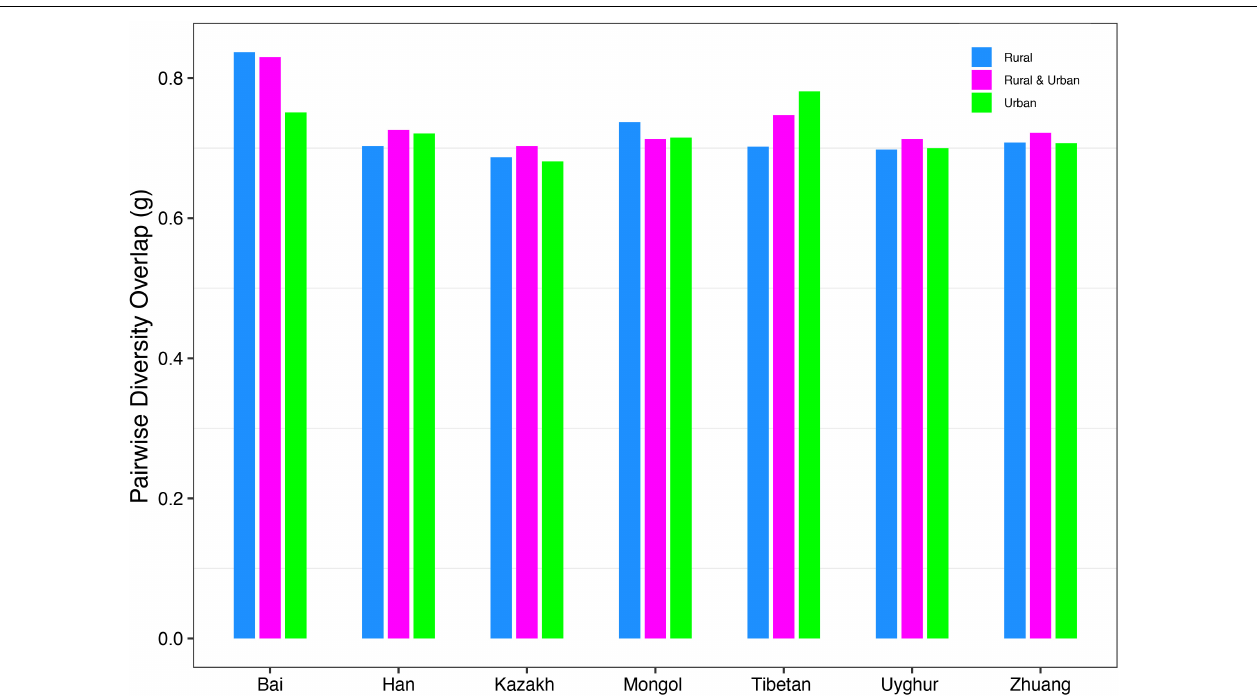
FIGURE 5 | The PDO profiles of all cohorts from Schemes 2A and 2B at the species level when diversity order q = 0.